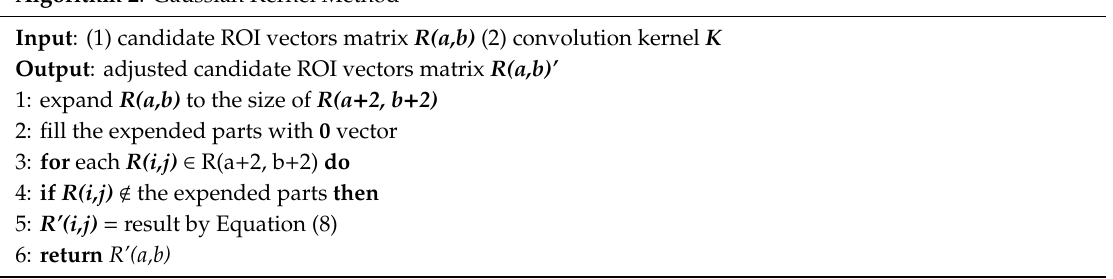
Algorithm 2 : Gaussian Kernel